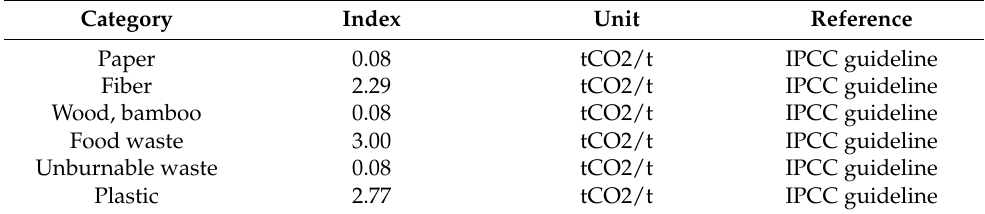
Table 5. Index applied in the study.